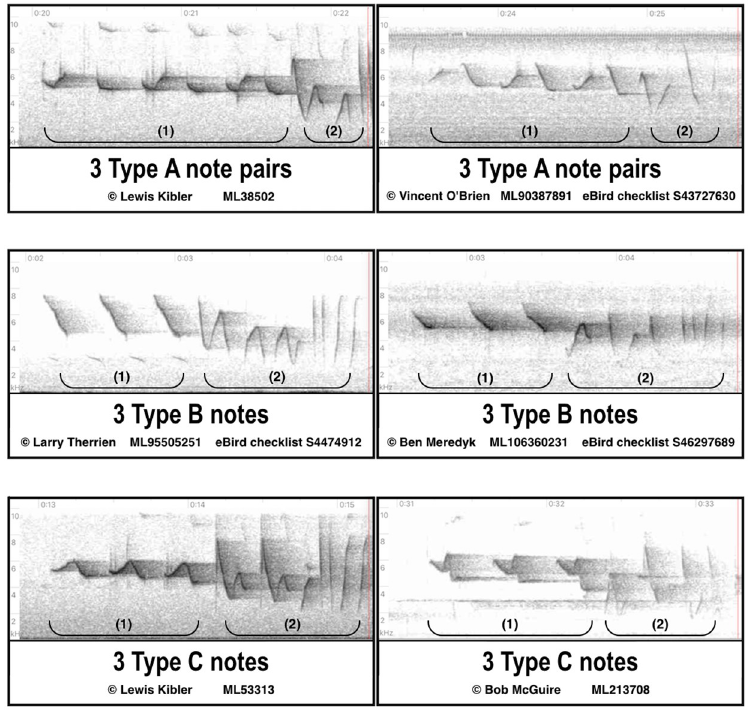
Fig 1. Spectrogram examples of the A, B, and C note types. Two examples of each note type have been selected from S1 Appendix. The analyzed introductory (1) and unanalyzed secondary (2) note sequences are designated by brackets; song type is determined solely by the introductory note sequence. Type A is comprised of alternating upstroke and downstroke note pairs, Type B employs downstrokes only, and Type C notes undulate both upwards and downwards.